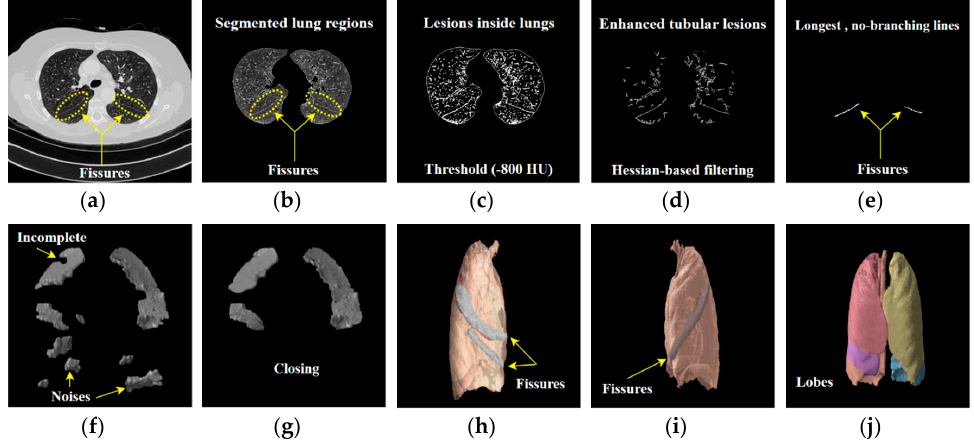
Figure 7. Segmentation of the pulmonary fissures and lung lobes: ( a ) input 2D CT slice, ( b ) segments of lung regions, ( c ) segments of lung internal structures, ( d ) enhanced tube-like structures, ( e ) possible 2D fissure lines, ( f ) isotropic view of possible fissures plane, ( g ) successfully segmented fissure planes, ( h ) transparent view of oblique and horizontal fissures in the right lung, ( i ) transparent view of oblique fissure in the left lung, ( j ) Successfully segmented lung lobes.